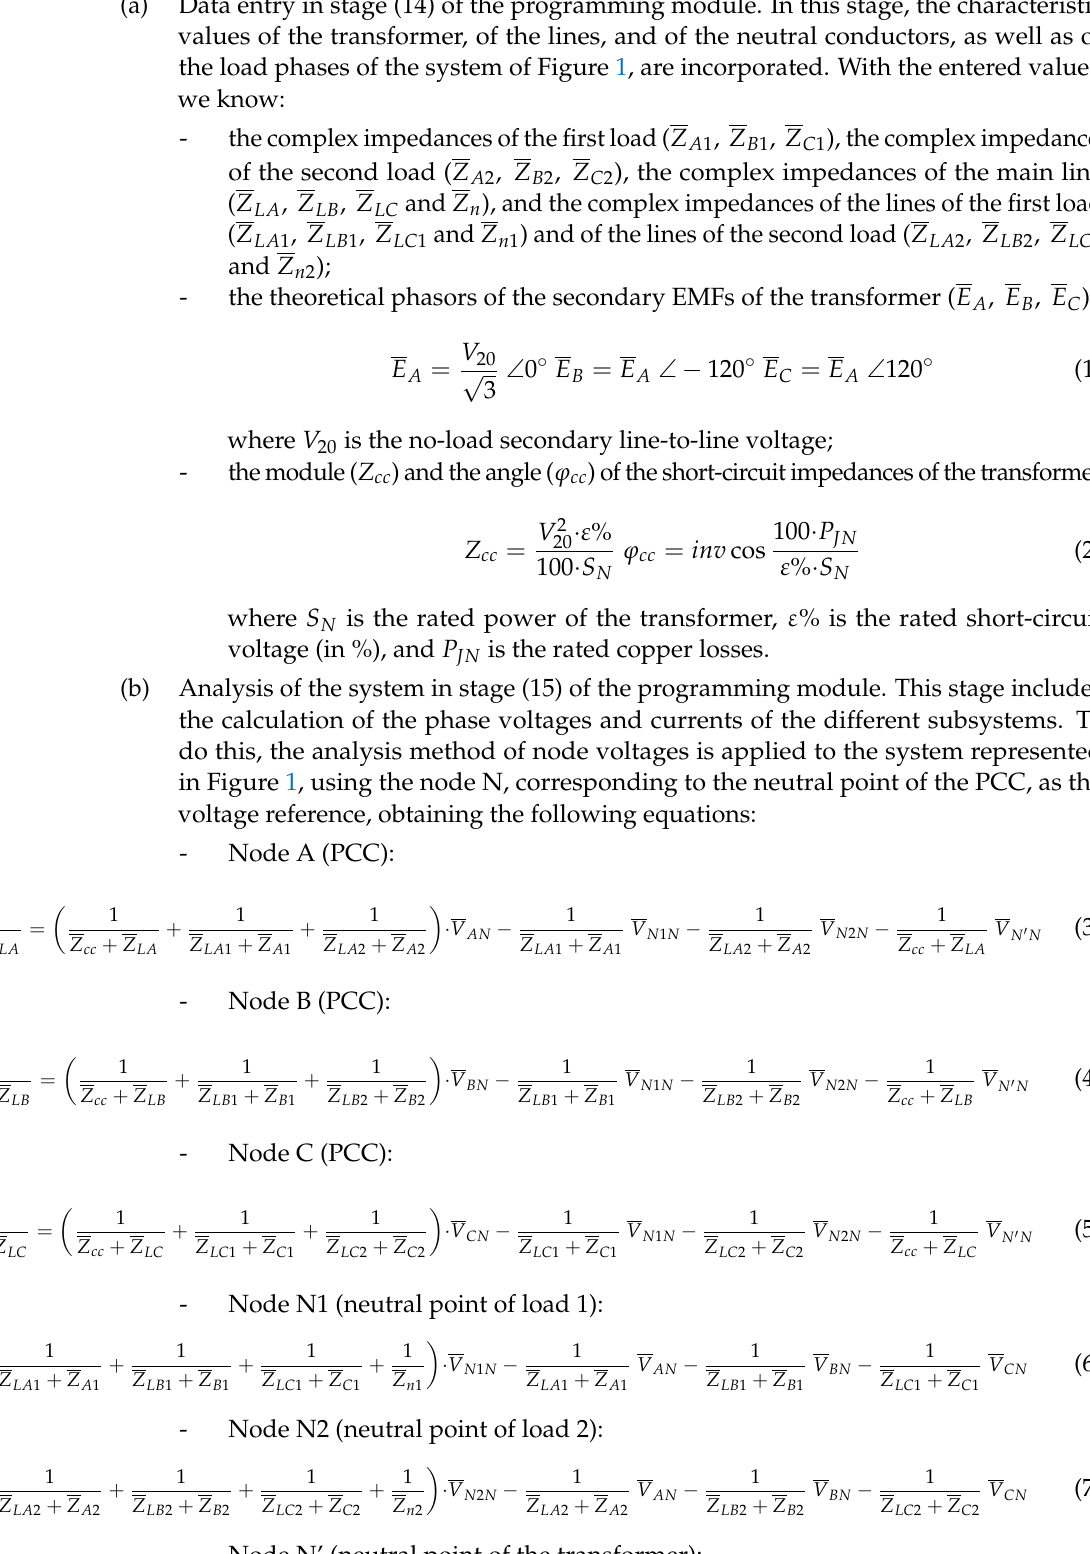
(a) Data entry in stage (14) of the programming module. In this stage, the characteristic values of the transformer, of the lines, and of the neutral conductors, as well as of the load phases of the system of Figure 1, are incorporated. With the entered values, we know: - the complex impedances of the first load ( Z A 1 , Z B 1 , Z C 1 ), the complex impedances of the second load ( Z A 2 , Z B 2 , Z C 2 ), the complex impedances of the main line ( Z LA , Z LB , Z LC and Z n ), and the complex impedances of the lines of the first load ( Z LA 1 , Z LB 1 , Z LC 1 and Z n 1 ) and of the lines of the second load ( Z LA 2 , Z LB 2 , Z LC 2 and Z n 2 ); - the theoretical phasors of the secondary EMFs of the transformer ( E A , E B , E C ),